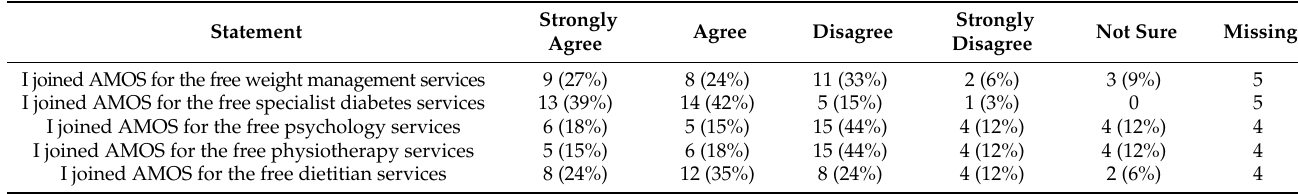
Table 1. Patient survey results—Theme 1: